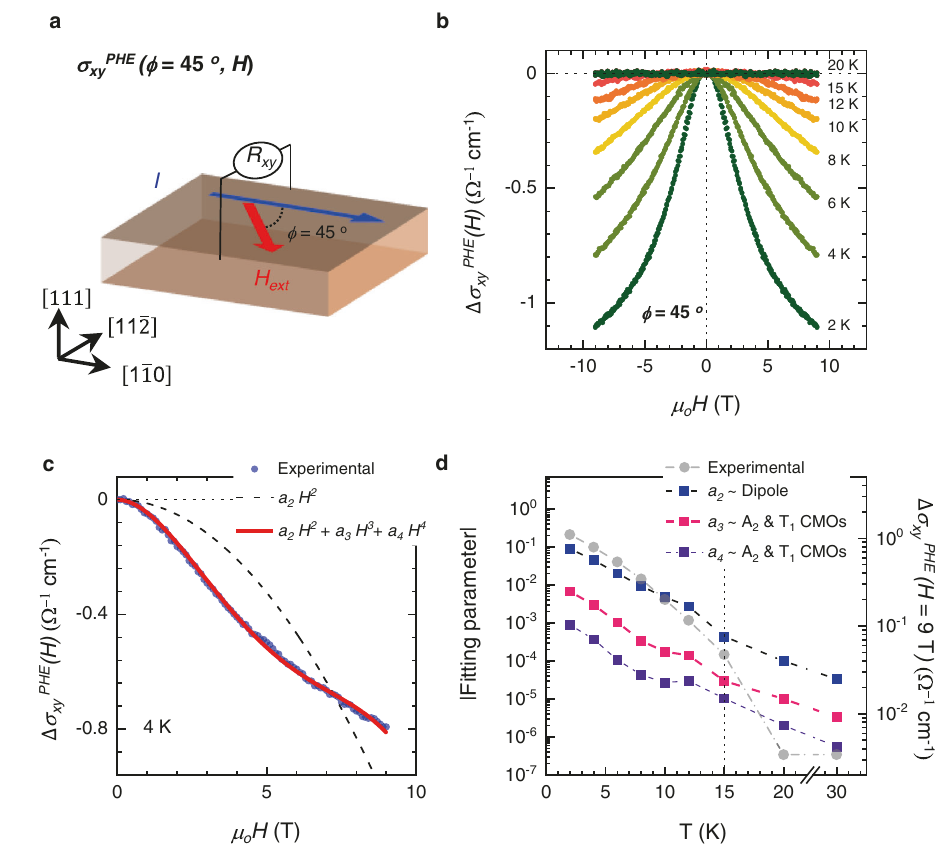
Fig.4|Nonlinearmagneticbehaviorofthe Δ σ PHE xy ð ϕ = 45 (cid:2) , H Þ oftheNIO-227thin with Δ σ PHE xy H ð Þ = a 2 H 2 + a 3 H 3 + a 4 H 4 (red line).The a 2 , a 3 , and a 4 terms correspond ð H Þ measurement geometry. In this geo- fi lm. a Schematic diagram of the Δ σ PHE to longitudinal magnetization, OM from the A 2 -CMO, and OM from the T 1 -CMO, xy metry,the anglebetweenthe currentand magnetic fi eld (±9 T )is45°.Surprisingly, respectively. Note thatwithout the a 3 and a 4 contributions (black dashed line), the Δ σ PHE ð H Þ shows H T ~ 15K due to OM. b Δ σ PHE ð H Þ curves as a experimental data (blue dots) do not fi t well, indicating the role of OM induced xy xy ext dependencybelow functionof H ext below T ~20K.Intheregionof15K< T <20K,thevalueof Δ σ PHE xy ð H Þ isnearlyzero.Theslightdeviationof Δ σ PHE xy ð H Þ near H ext ~ ±9 T at T ~15Kispossibly due to dipolar order. c Logarithmic plot of the results of fi tting Δ σ PHE xy ð H Þ at T ~ 4K